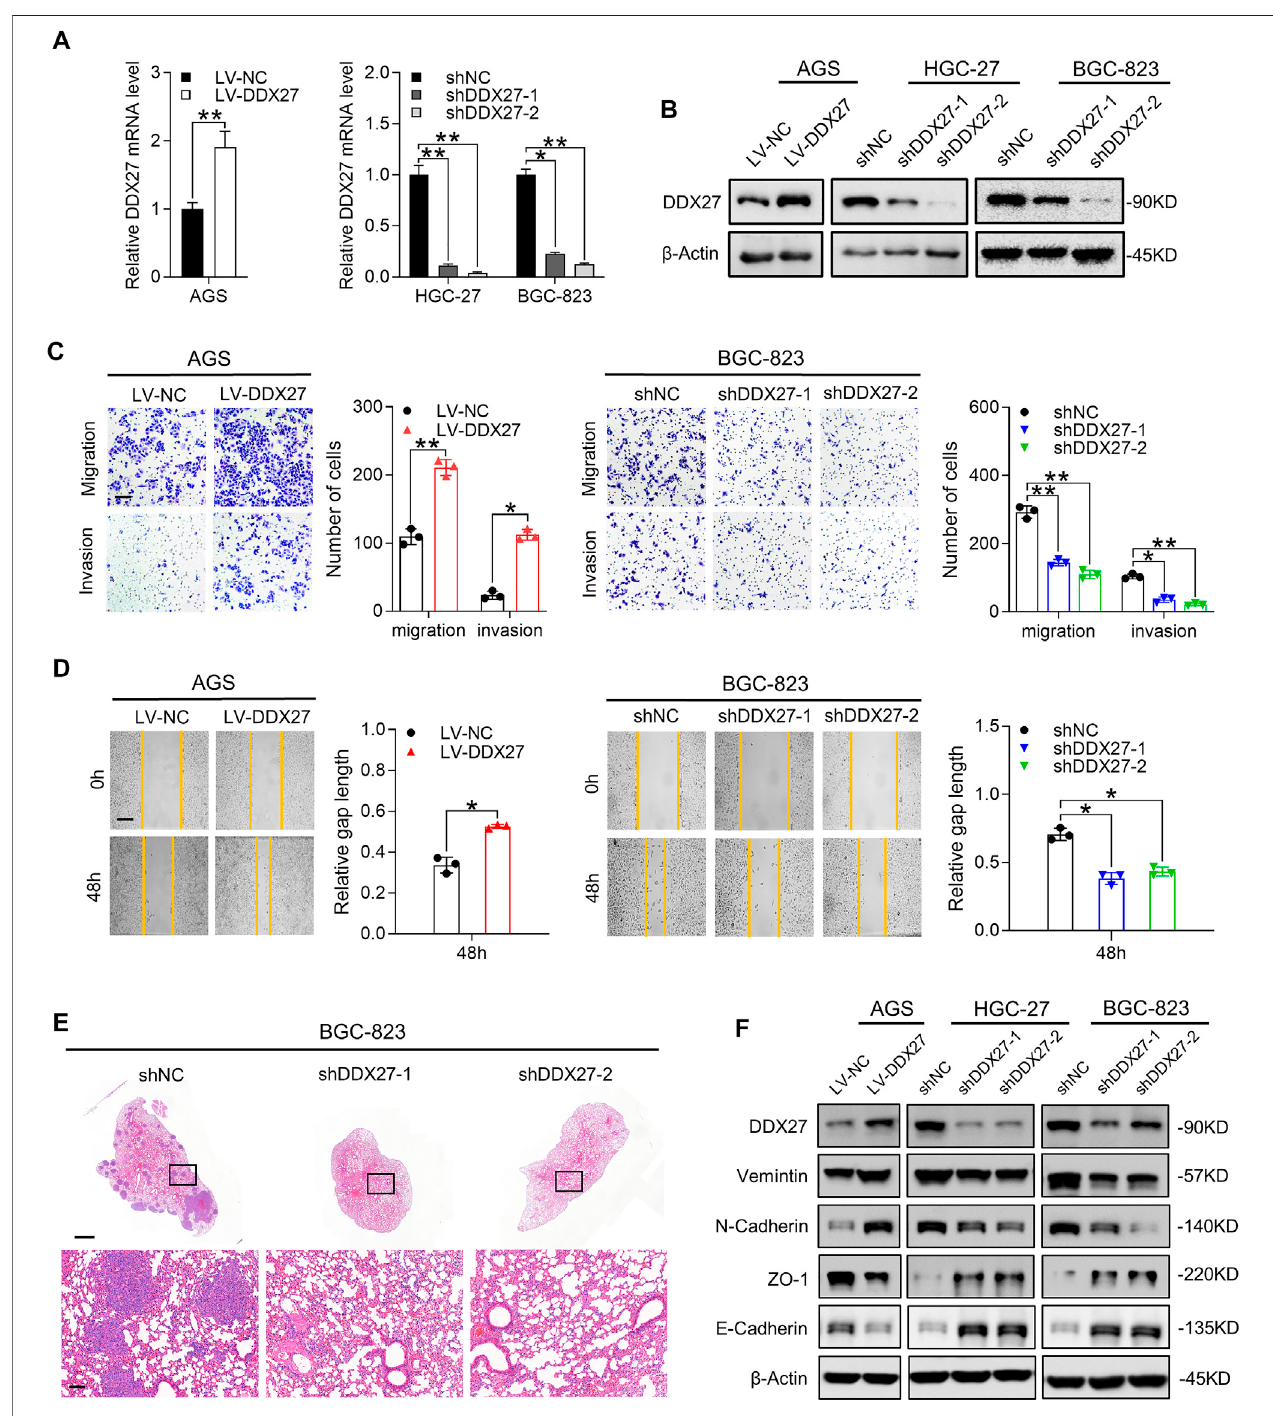
FIGURE 3 | DDX27 is a critical mediator of GC metastasis via EMT. (A,B) Transcript level (A) and protein expression (B) of DDX27 in DDX27-knockdown and overexpressedcellmodels(** p < 0.01,* p < 0.05,byANOVA). (C) Metastaticabilityassessedbytrans-wellassayforDDX27-overexpressedand-knockdowncellmodels (left, overexpression vs. control; right, knockdown vs. control). Scale bars: 12.5 μ m (** p < 0.01, * p < 0.05, by ANOVA). (D) Wound healing and statistical analysis for indicated cells (left, overexpression vs. control; right, knockdown vs. control) Scale bars: 25 μ m. (* p < 0.05, by ANOVA). (E) Hematoxylin-eosin (H,E) staining for metastatic nodules in the dissected lung specimen from nude mice (10 mice in each group). Scale bars:1,000 μ m (up) or 100 μ m (below). (F) Protein level of EMT markers (E-cadherin, N-cadherin, vimentin, and ZO-1) among the indicated GC cells. n ≥ 3, the data are presented as mean ± SD. LPP is indispensable for DDX27- mediated GC migration and